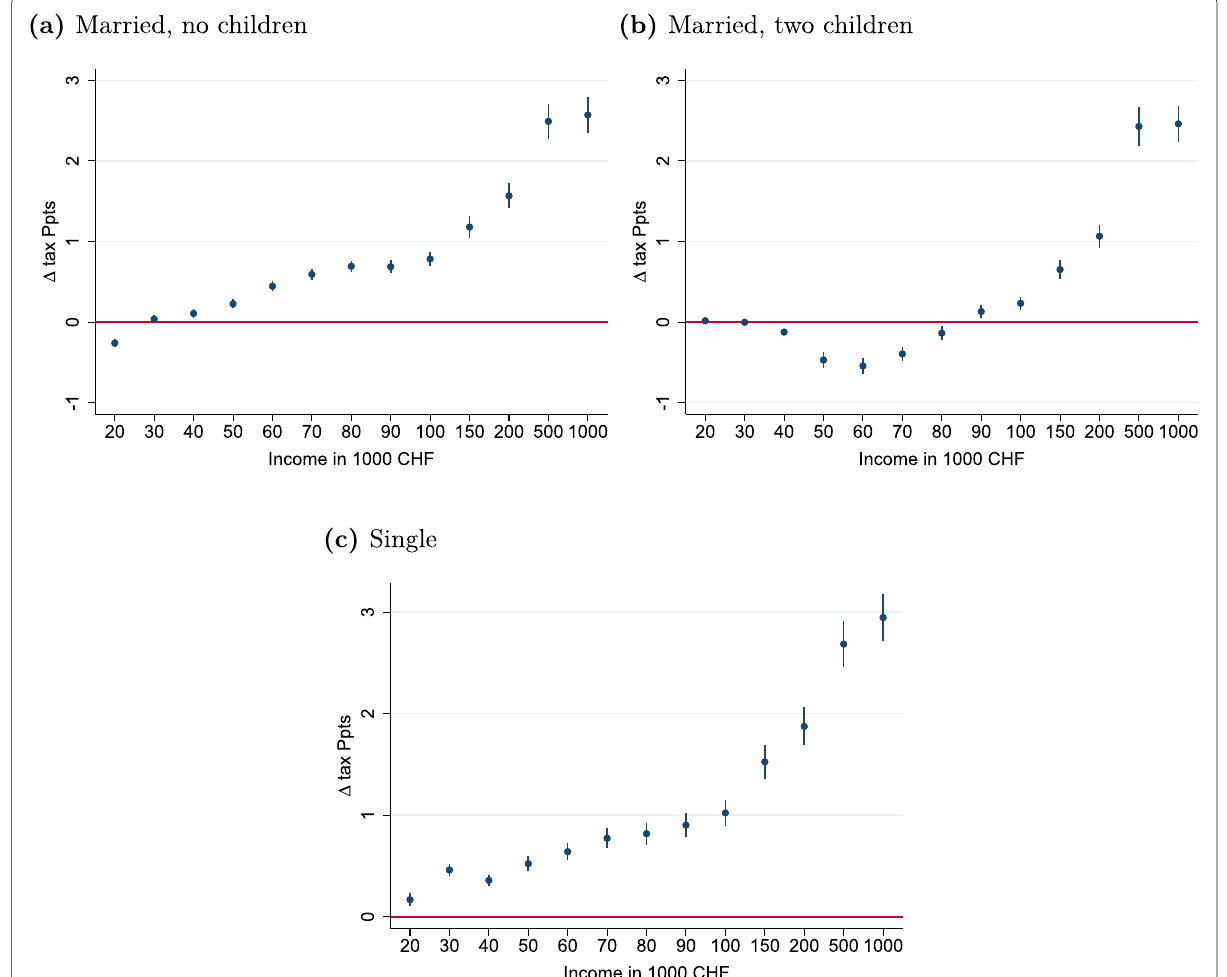
Fig. 6 Estimated differential change in cantonal income tax between the cantons with regulation and control cantons for different incomes (CHF 20,000 to CHF 1,000,000) and for different types of tax payers (married, married with two children, single). Each dot shows a coefficient estimate μ y 2 of Eq. 2 and its 95% confidence interval, i.e., the differential change in income taxes for an individual with income y given they are married, married with two children, or single. The corresponding estimates are displayed in Appendix Table